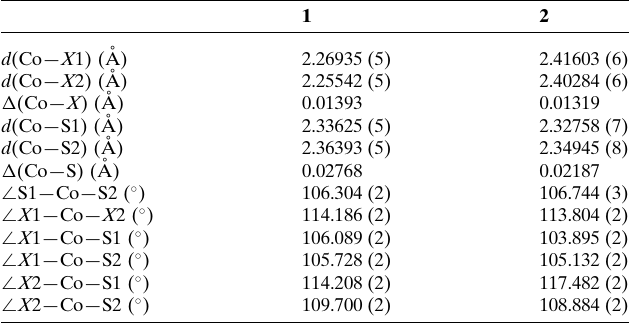
Table 2 Selected geometrical parameters extracted from the 20 K crystal structures of 1 and 2 .